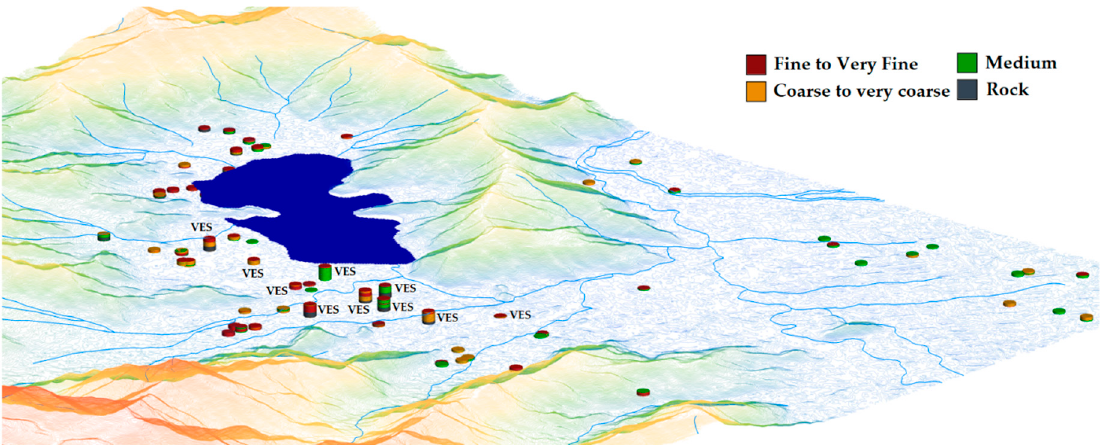
Figure 3. Boreholes and vertical electric sounding (VES) locations used to construct a geological model for the Aculeo domain. The legend represents a simplification of the textural classes found in the lithographic sampling intervals.